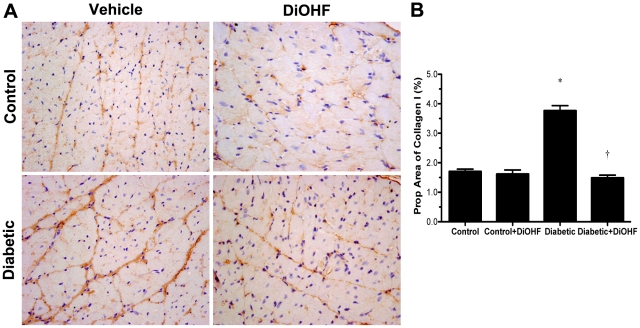
Immumohistochemistry staining for collagen type I.(A) Representative images. Brown region represents positive immunostaining for collagen type I which was substantially increased in diabetic rats and reduced by DiOHF treatment. The amount of collagen type I was found to be similar in control and control-treated rats. Collagen type I interstitial accumulation as assessed by percentage proportional area showing positive immunostaining in control and diabetic rats treated with or without DiOHF (B). Data expressed as mean ± SE. *P<0.05 vs control (non-diabetic) rats; †P<0.05 vs diabetic rats. Original magnification ×200.